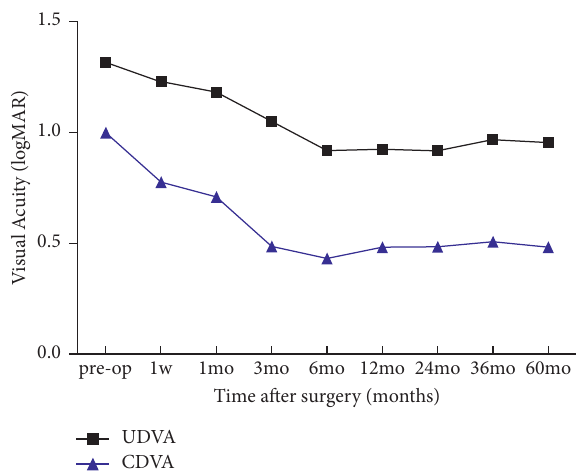
Figure 1: There was no significant change in preoperative UDVA compared with UDVA at 60 months postsurgically ( F � 3.215, P � 0 . 081). The CDVA showed significant improvement at 60months � 0 . 026), and this result 3 months postsurgically ( P 3months remained constant thereafter. (CDVA � corrected distance visual acuity; logMAR � logarithm of the minimum angle of resolution; UDVA � uncorrected distance visual